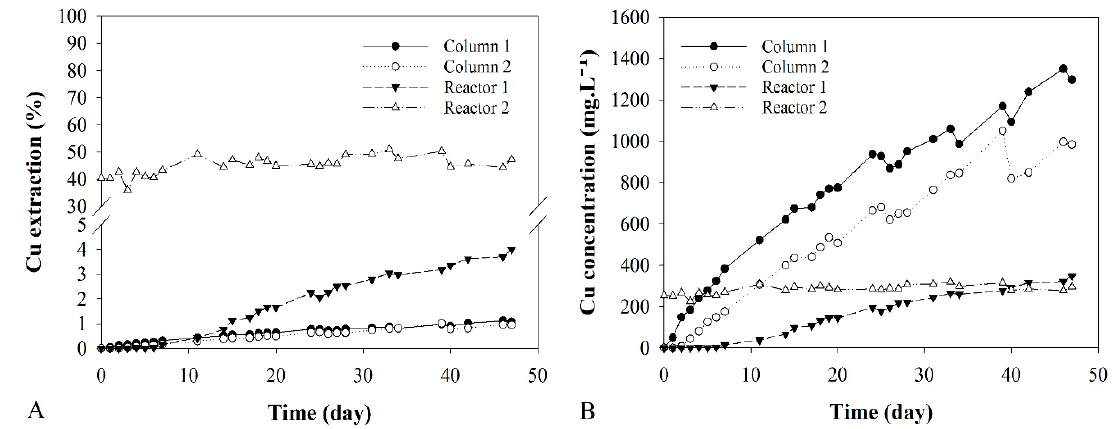
Figure 8. Copper extraction (%) efficiency ( A ) and soluble copper concentration (mg · L − 1 ) in the pregnant solution ( B ) along the sulfide (reactor 1) and weathered (reactor 2) ores bioleaching experiment using A. ferrooxidans .